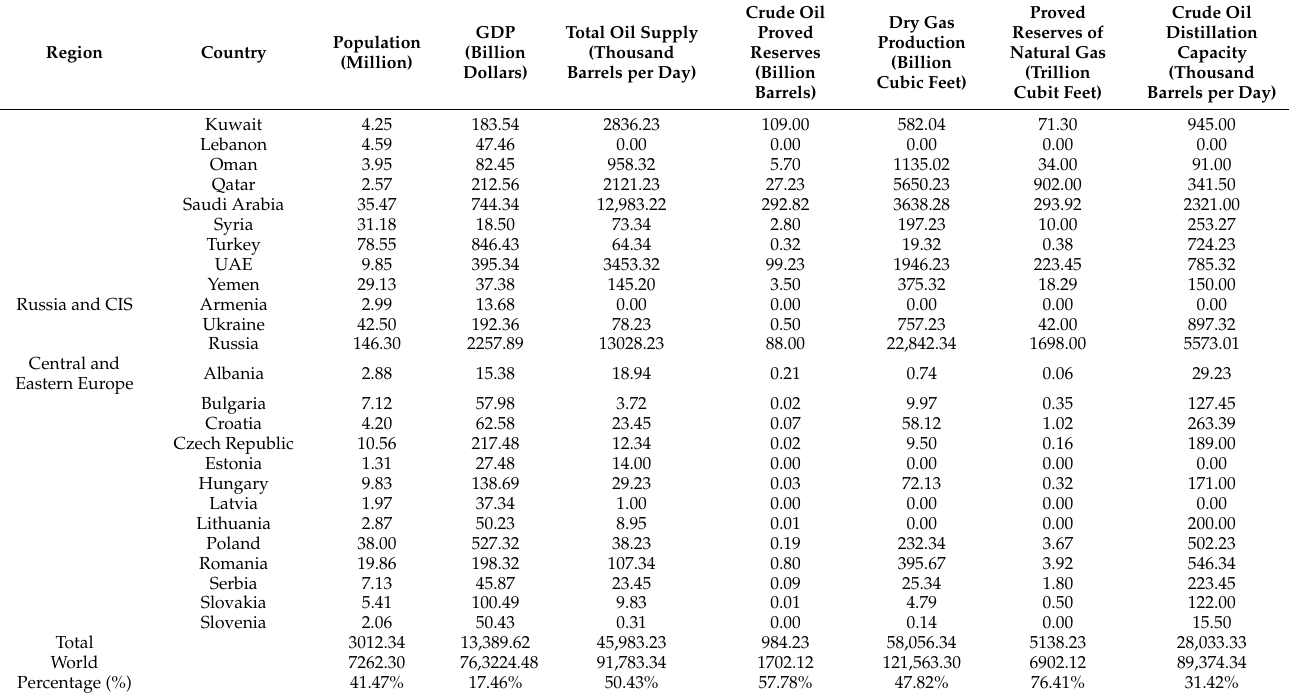
Table A5. Main statistics of 50 Nations alongside the China’s “Belt & Road Initiative in 2017”.